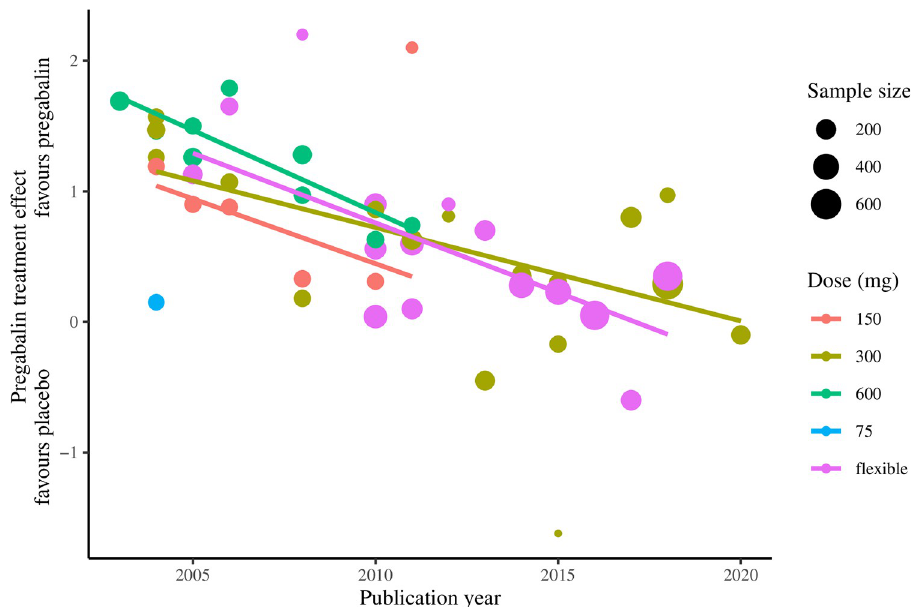
Fig 6. Treatment effect of pregabalin over publication year � by dose. � Derived from unadjusted meta-regression models. Subgroups with two or fewer studies were not evaluated. Abbreviations: DPN, diabetic peripheral neuropathy; AHN, acute herpetic neuralgia; central NP, central neuropathic pain; HIV, human immunodeficiency virus-associated neuropathy; PHN, post-herpetic neuralgia.